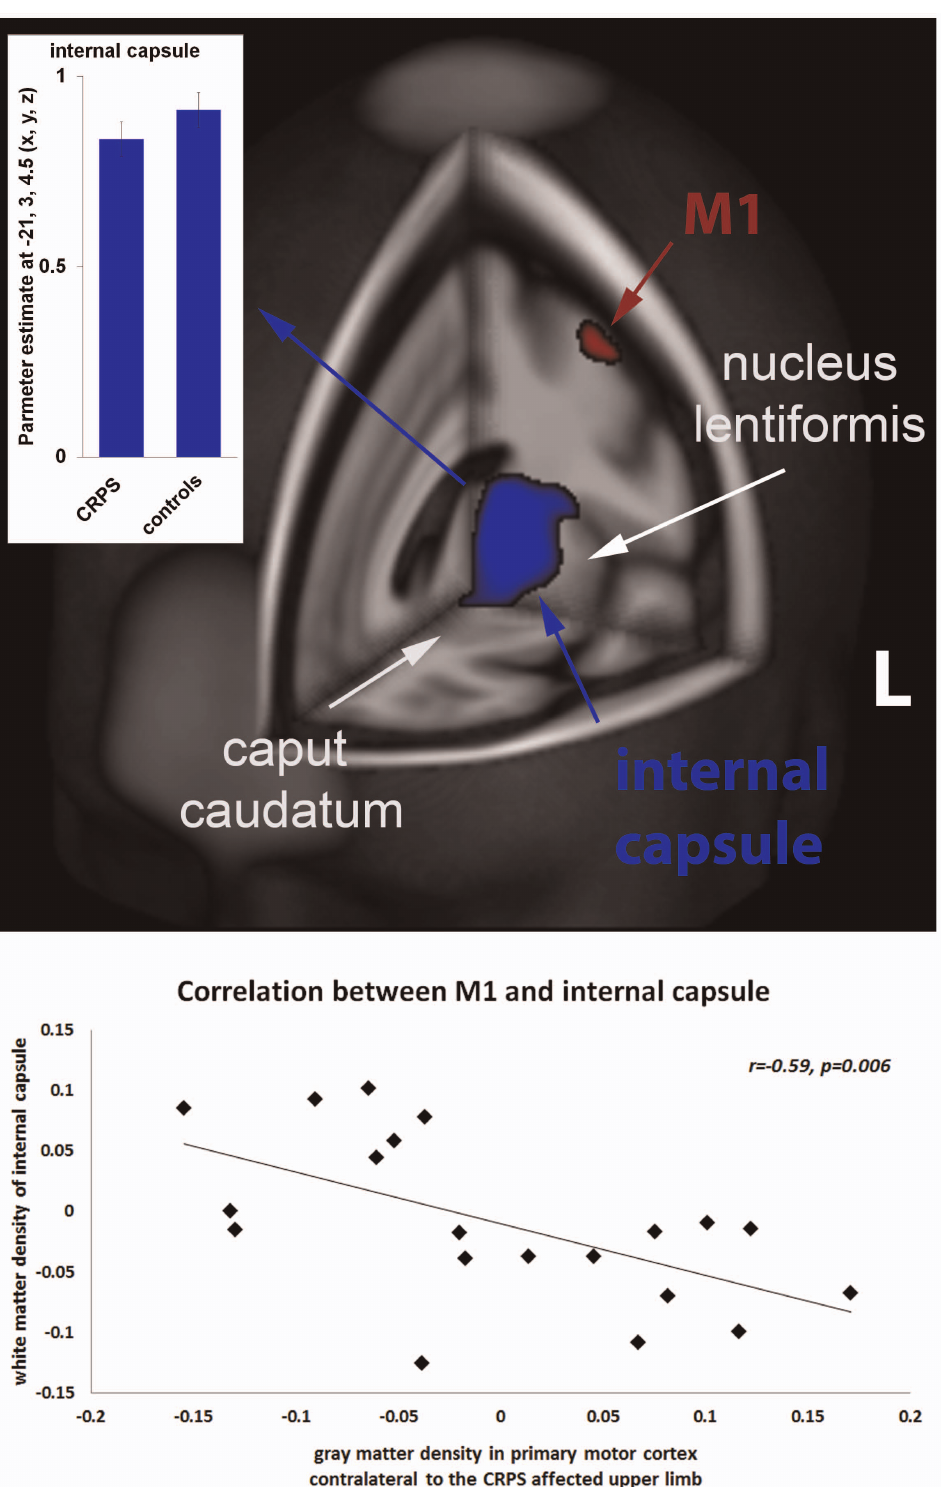
Figure 3. Voxel-wise VBM statistics of whole brain white matter structure revealed one significant cluster with decreased white matter density when comparing CRPS patients to matched controls (see blue cluster, peak voxel-level: – 21, 3, 4.5 (x, y, z, mm), T=4.07, p , 0.001 uncorrected, cluster-level: 789 voxels, p=0.014 FWE corrected). This cluster was located in the internal capsule, known to contain the projections from the M1 to the brainstem. In agreement with this anatomical implementation, we found that reduced individual white matter density negatively correlated (see scatter plot) with increased gray matter density we found in primary motor cortex (M1, see red cluster and Fig. 2). The red diamonds indicate patients with left-sided CRPS. Bar plot indicates estimated gray matter changes of the peak voxel; whiskers the standard error. doi:10.1371/journal.pone.0085372.g003 PLOS ONE |